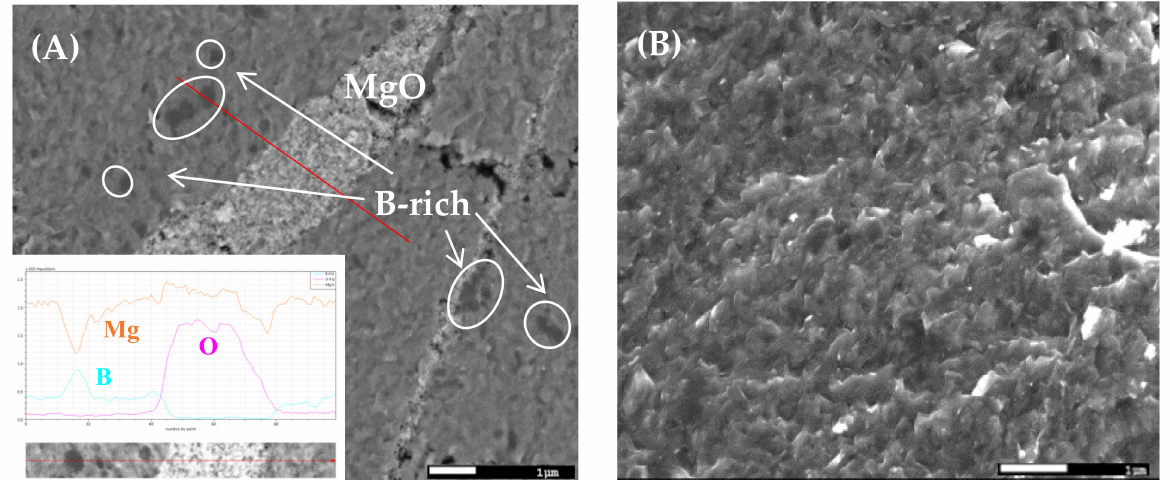
Figure 2. ( A ) SEM micrograph of sample A showing the unreacted boron and MgO regions in the MgB 2 matrix. ( B ) High-magnification SEM image of nano MgB 2 grains. The inset of Figure 2A shows the EDS red-line region scan curves of boron (cyan line), oxygen (magenta line) and magnesium (orange